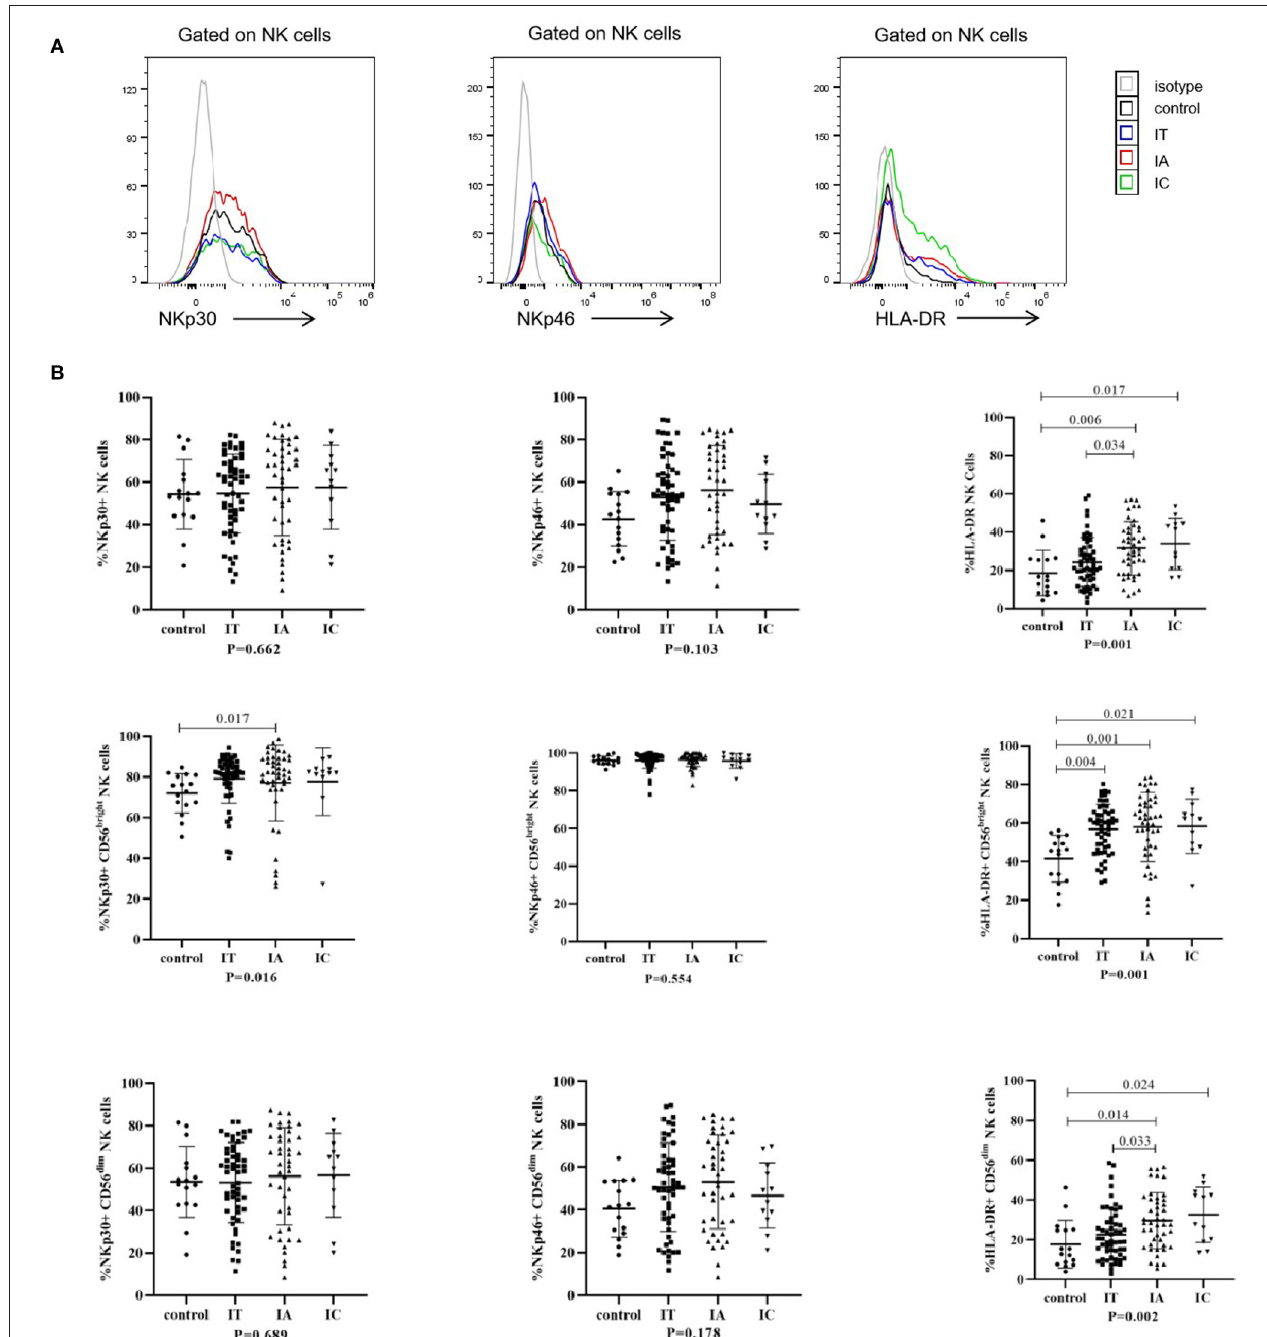
FIGURE 1 | Phenotypes of natural killer (NK) cells in different clinical phases. (A) Representative flow histogram plots of NKp30, NKp46, and HLA-DR on NK cells. (B) Frequencies of NKp30, NKp46, and HLA-DR on NK cells. The p -values below the abscissa represent the results of the Kruskal–Wallis test of the four groups. Numbers above the lines represent the p -values of the multiple pairwise comparison with statistical significance. A value of p < 0.05 is considered statistically significant.